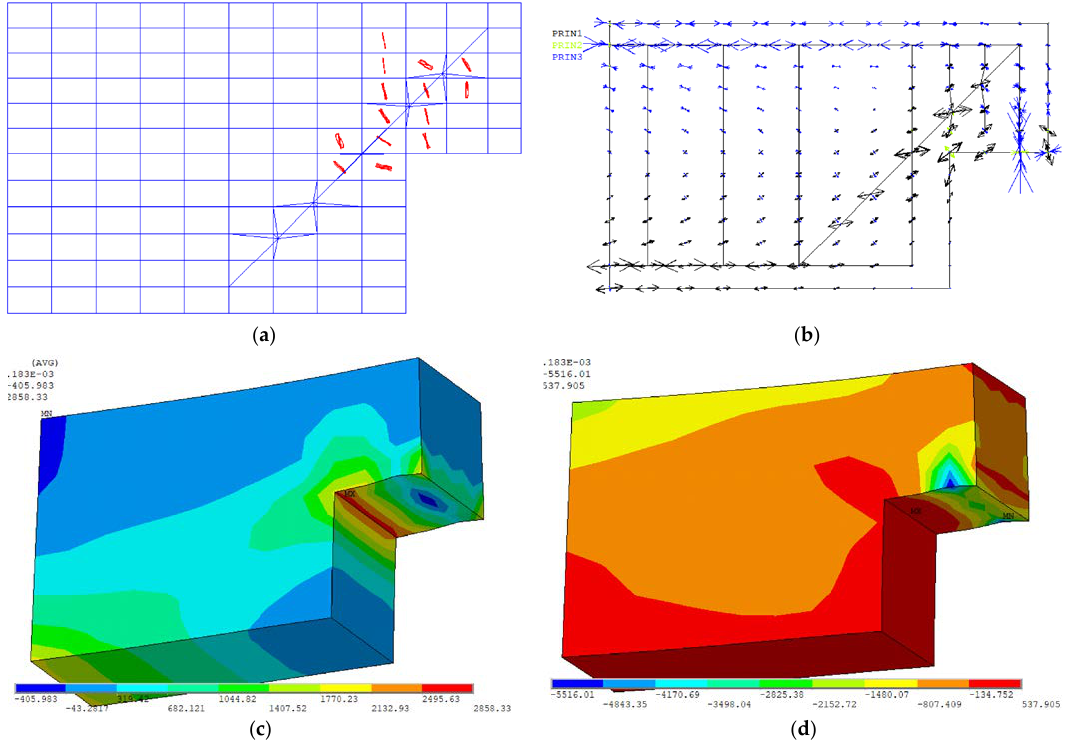
Figure 17. Half-joint in NS-NU configuration. ( a ) Cracking surfaces at collapse (86% final load); ( b ) vector plot of principal stresses just before collapse; ( c ) 1st principal stress just before collapse [kN/m 2 ]; ( d ) 3rd principal stress just before collapse [kN/m 2 ].